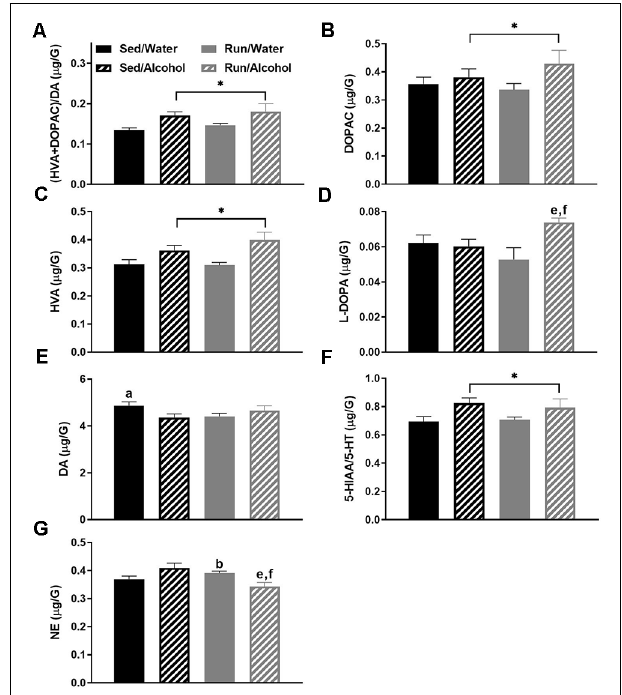
FIGURE 3 | Neurochemical levels in the mouse striatum area immediately following the final DID session. Ratio of (HVA + DOPAC)/DA (A) , DOPAC concentrations (B) , HVA concentrations (C) , L-DOPA concentrations (D) , DA concentrations (E) , ratio of 5-HIAA/5-HT (F) , NE concentrations (G) . Data represent means +SEM. ∗ P < 0.05 main effect alcohol access, a P < 0.05 Sed/Water from Sed/Alcohol, b P < 0.05 Sed/Water from Run/Water, e P < 0.05 Sed/Alcohol from Run/Alcohol, f P < 0.05 Run/Water from Run/Alcohol.